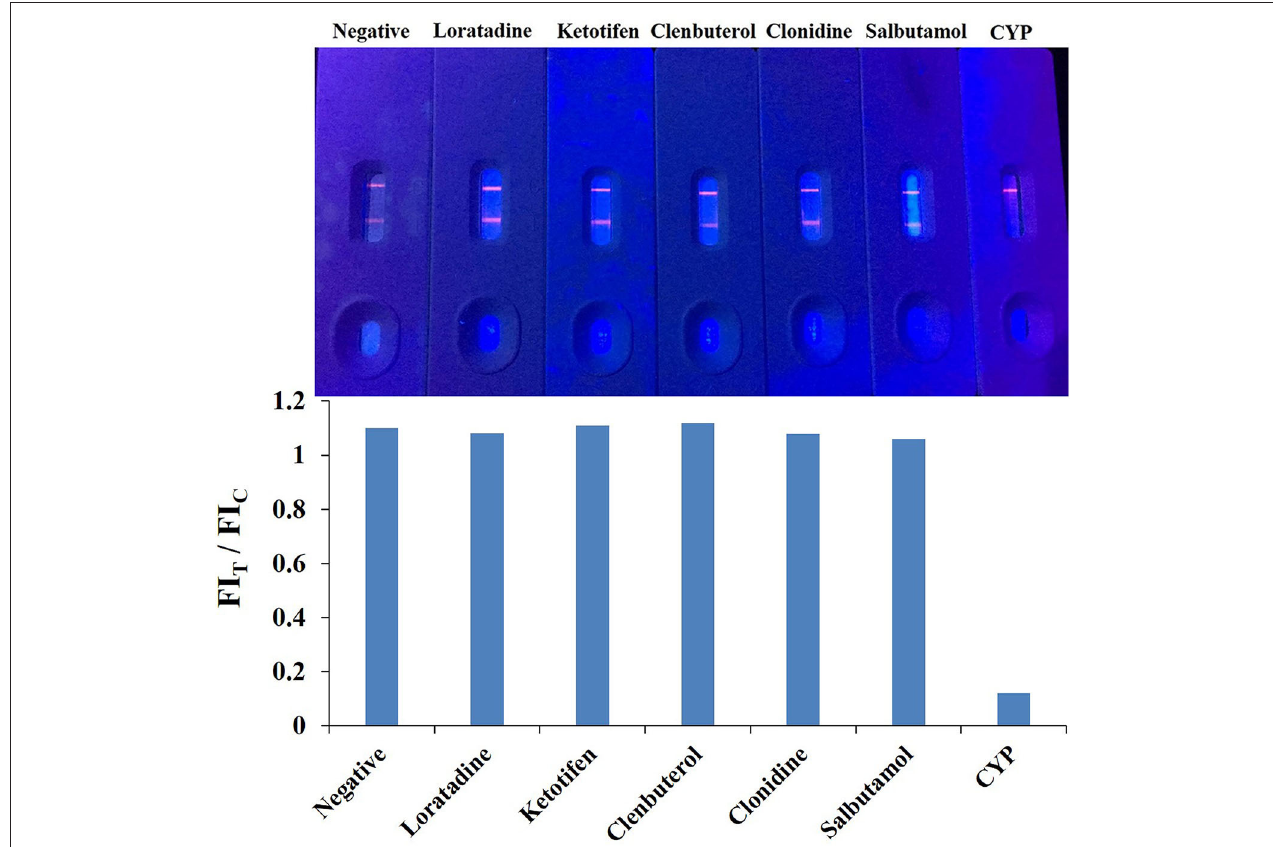
FIGURE 5 | Cross-reactivity study of QBs-ICA against CYP (1ng/mL) and other analogs (1 µ g/mL).